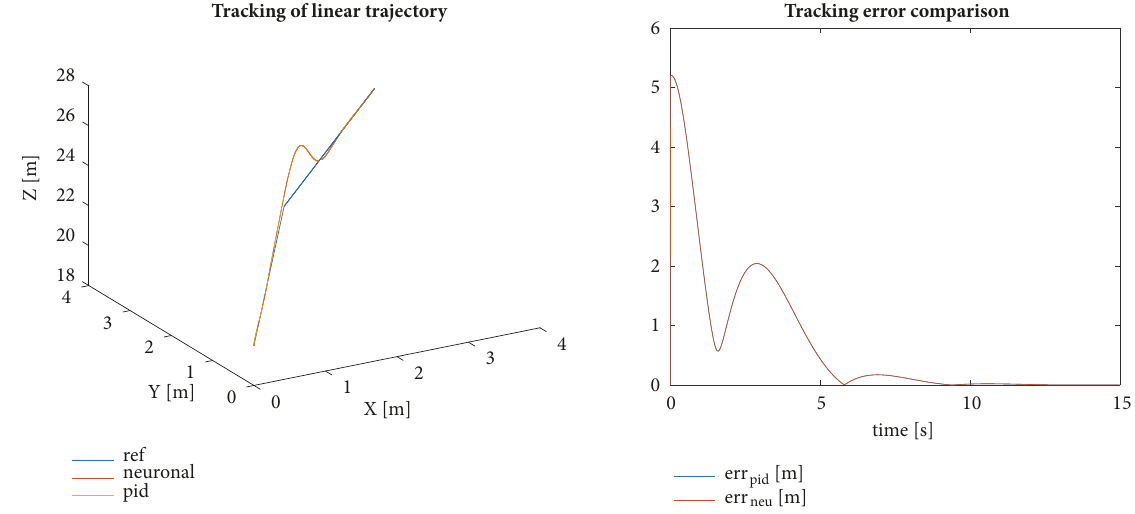
Figure 6: UAV tracking of a linear trajectory (left) and its tracking error